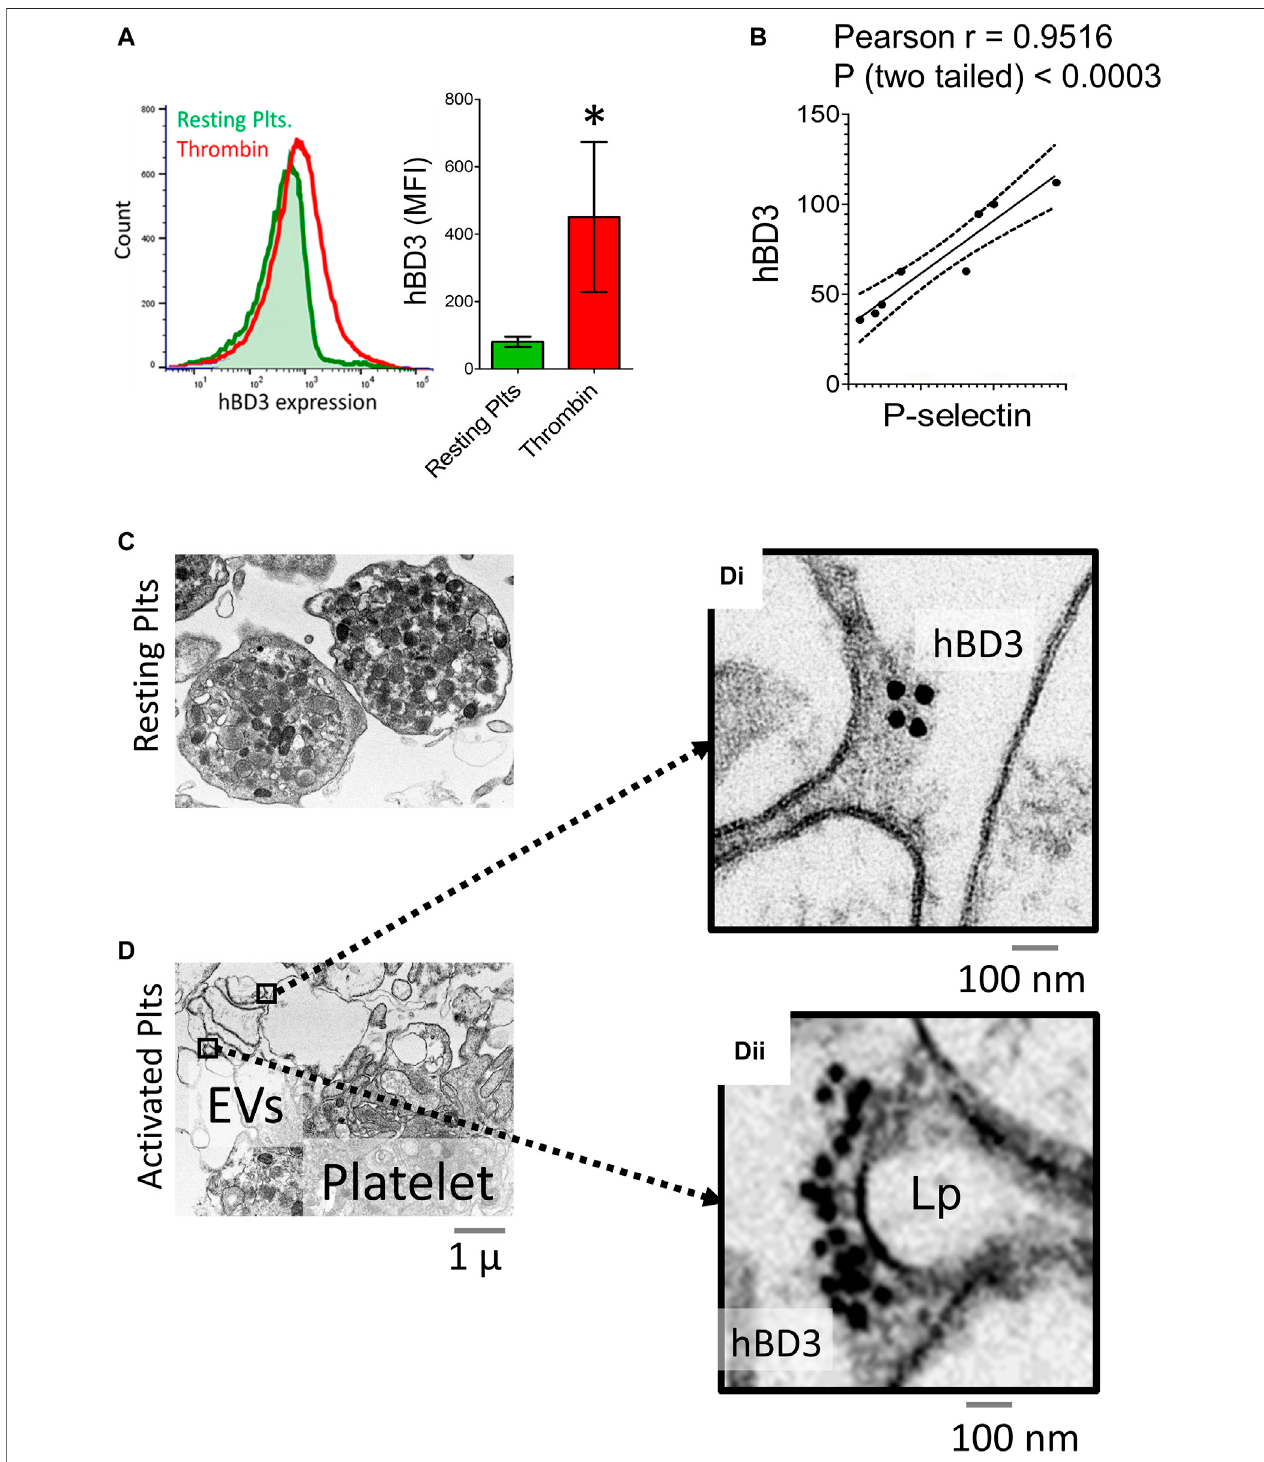
FIGURE 2 | Activated gel-puri fi ed platelets express increased levels of Human β -defensin 3 (hBD-3) on the surface. (A) Histogram from representative fl ow cytometry experiment showing surface expressions of hBD-3 in resting and thrombin activated GPP (left panel); Mean fl uorescence intensity values indicating surface hBD-3 (middle panel) expression in resting and thrombin activated platelets ( n = 6, p < ). (B) Ratios of mean fl uorescence intensity for surface expressions of P-selectin ( x -axis), and hBD-3 (y-axis) in ADP (5 μ M) and Thrombin (0.05 U/ml) activated platelets. Each dot represents one pair ofobservation from the same sample ( n = 8). Electron microscopic images of resting (C) and thrombin activated (D) platelets immuno-stained with primary anti-hBD-3 and gold-nanoparticle conjugated secondary antibodies. Gold nanoparticles on thrombin activated platelet surface [ (D) i, ii right] and on EV/Lamellipodium (Lp) are shown with higher magni fi cation.